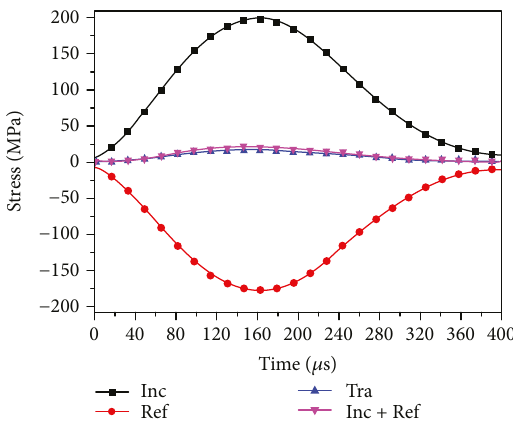
Figure 4: Dynamic stress equilibrium of a typical SHPB test. Inc: incident stress; Ref: re fl ected stress; Tra: transmitted stress. The ID of the sample is